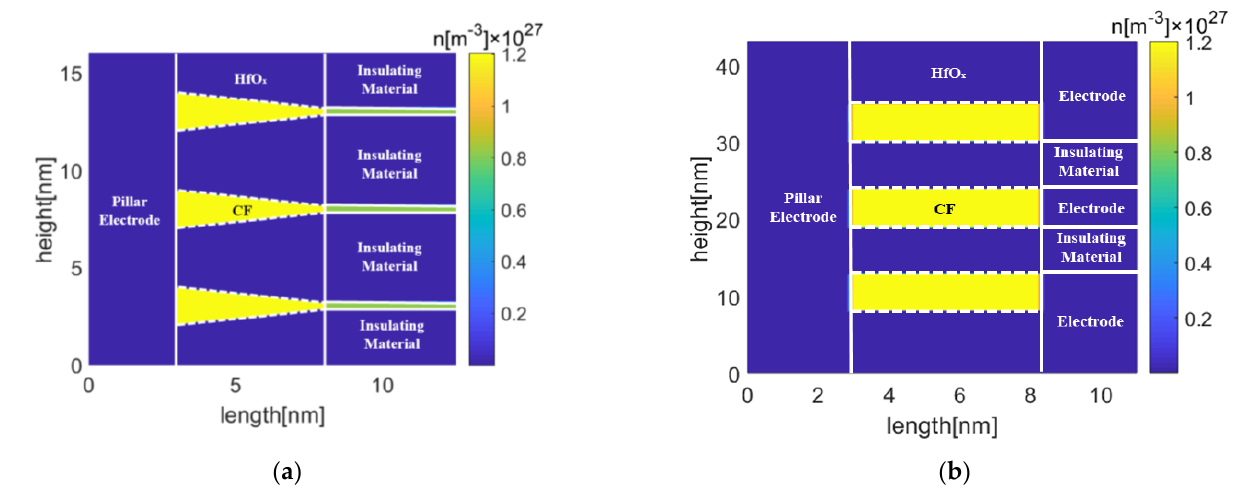
Figure 5. Oxygen vacancy density distributions for the ( a ) GE-RRAM and ( b ) Pt-RRAM, in which both the top and bottom cells are active, and captured at 0 s.